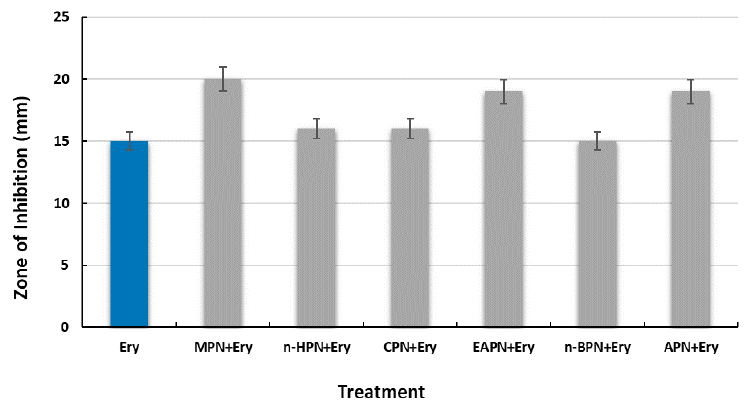
Figure 3. Antibiotic reversal activity of P. nigrum extracts in combination with erythromycin (15 μg) for S. aureus.